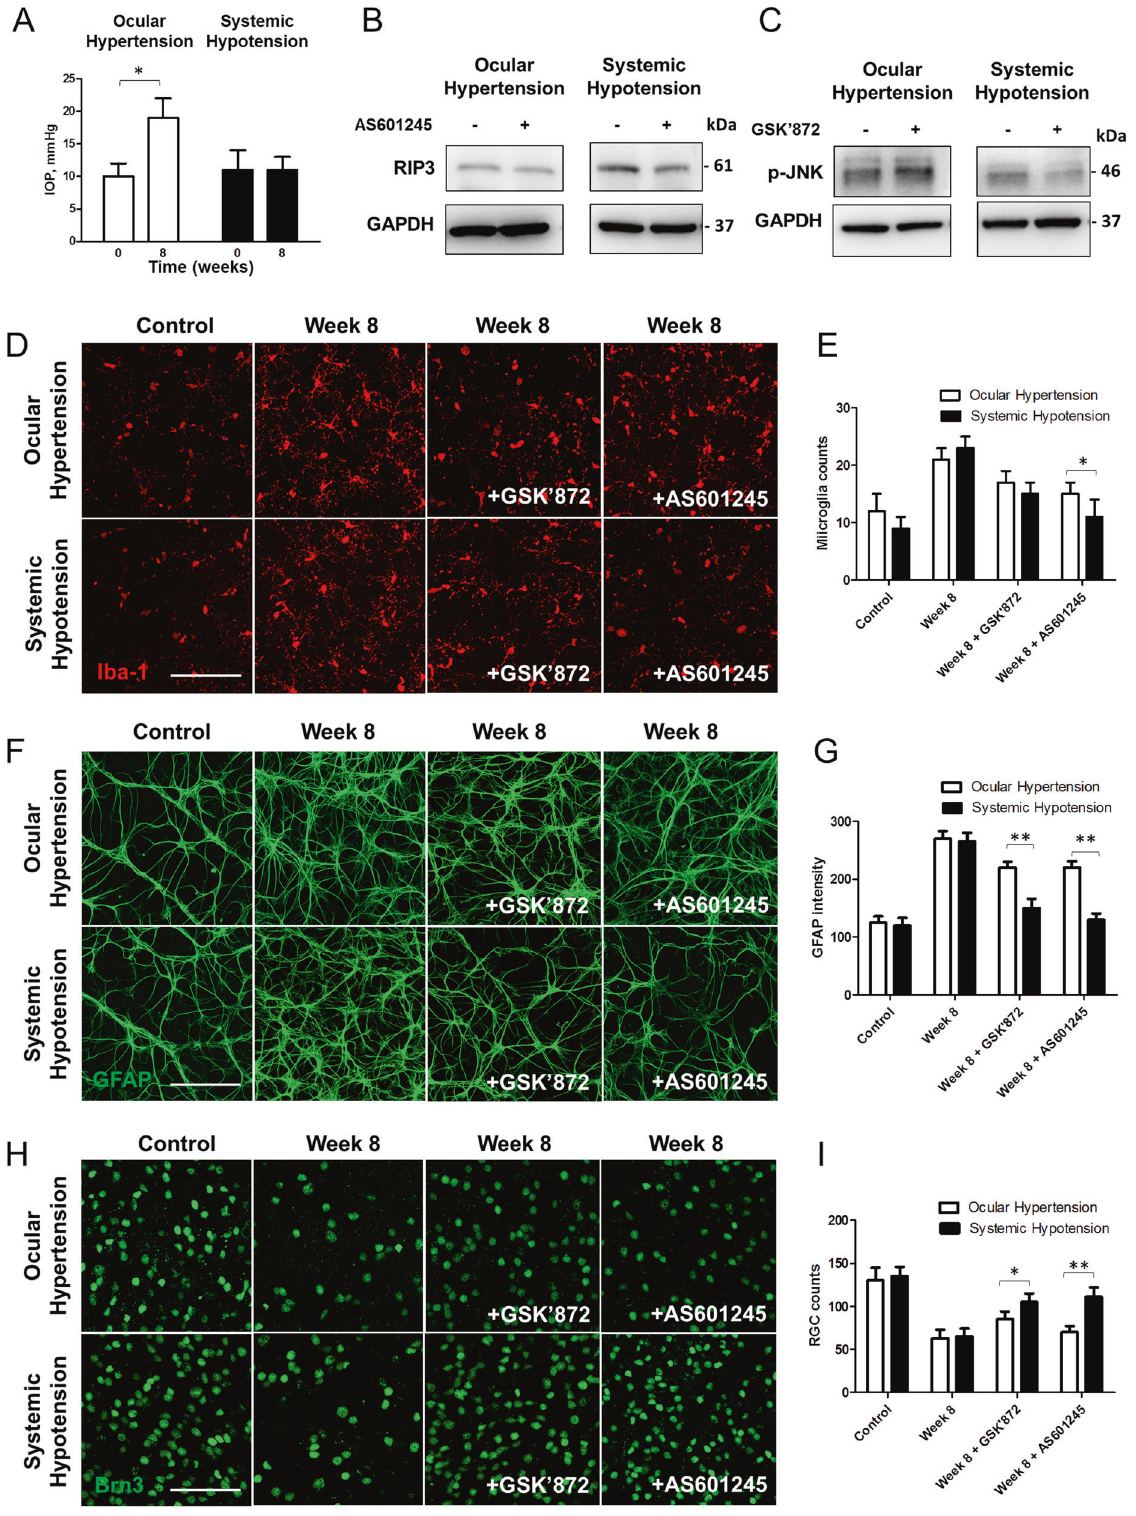
Fig. 6 Comparisons between systemic hypotensive rats and ocular hypertensive rats. A Intraocular pressure (IOP) was signi fi cantly elevated after 8 weeks of experiment. B , C Western blots of RIP3 and p-JNK were performed with or without GSK ’ 870 or AS601245 at week 8 in each model. Signi fi cant downregulation of RIP3 and p-JNK was observed only in systemic hypotensive rats when administered GSK ’ 870 or AS601245. For western blot analysis, n = 6 for control and n = 6 for systemic hypotension at week 8; total n = 24. Bar represents mean ± SD. Student ’ s t -test was used for statistical evaluation. * P < 0.05 compared to the control. D , F , H Immunohistochemical staining and E , G , I western blots of Iba-1, GFAP, and Brn3a. GSK ’ 870 or AS601245 administration made alterations of expression only in systemic hypotensive rats. Scale bars: 50 μ m. For immunohistochemical staining, n = 6 for control and n = 6 for systemic hypotension at each time period; total n = 48. Bar represents mean ± SD. Student ’ s t -test was used for statistical evaluation. * P < 0.05 and ** P < 0.01 compared to the control. Cell Death and Disease (2022)